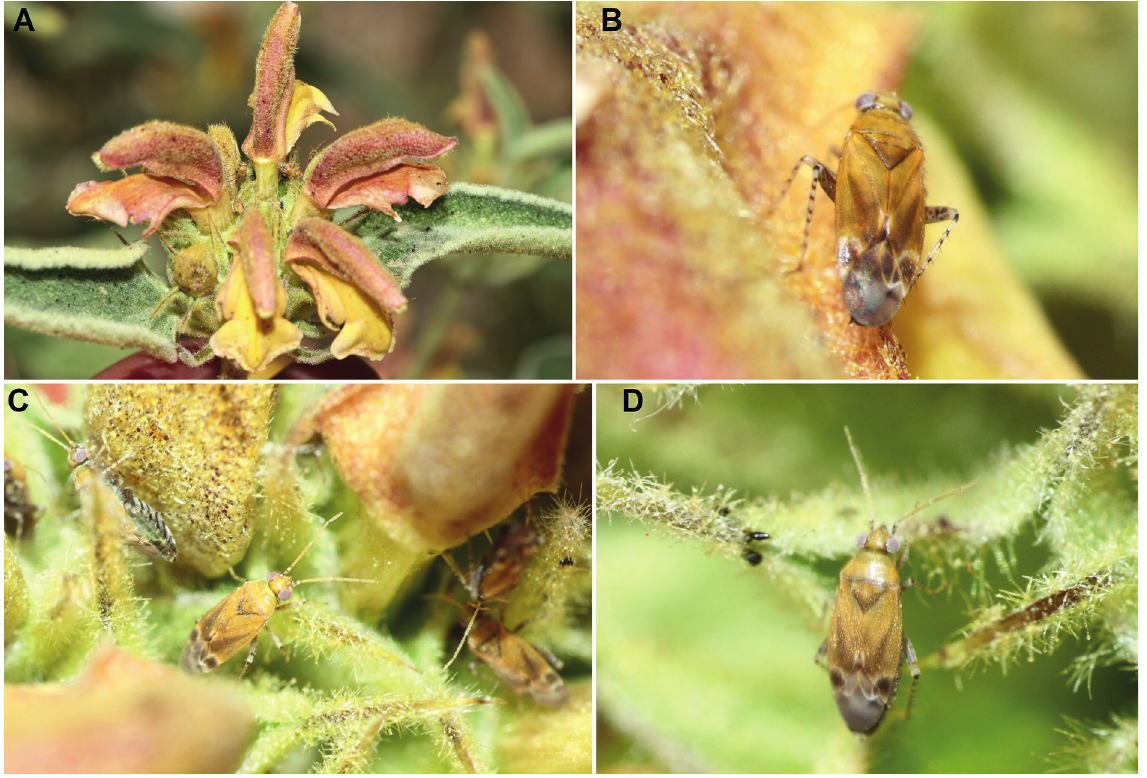
Fig. 1. Plagiognathus ozgurkocaki sp. nov. A . Colony on Phlomis leucophracta P.H.Davis & Hub.- Mor. B . ♂. C . ♀. D . ♀. Photographs: Özgür